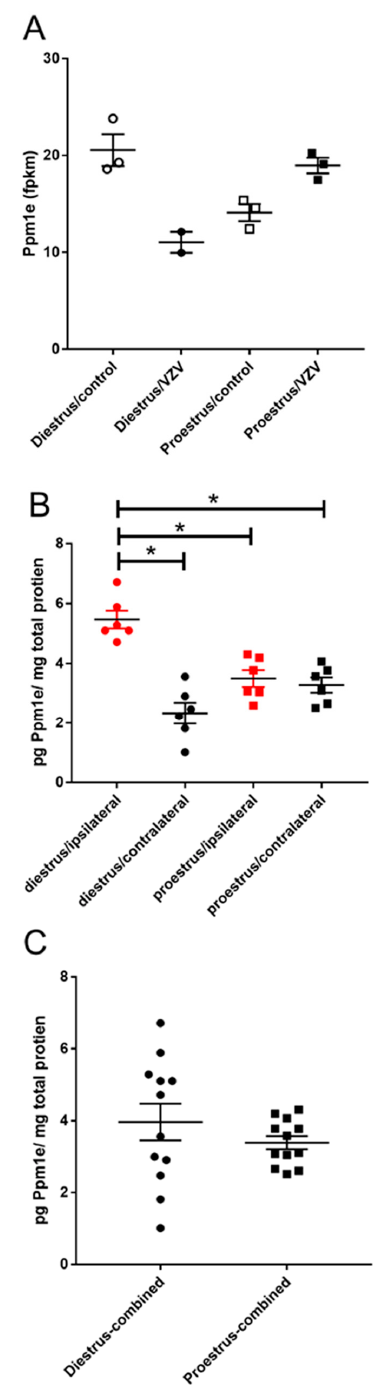
Figure 5. Expression of protein phosphatase, Mg 2 + / Mn 2 + dependent 1E (Ppm1e) significantly increased in the parabrachial region at diestrus. Rats were injected with varicella zoster virus in the left whisker pad to induce orofacial pain. Parabrachial brain tissue was collected from these female rats during the proestrus and diestrus phase of the estrous cycle. This tissue was analyzed for RNA (panel A ) and protein (panels B , C ). In panel ( B ) the right (contralateral to VZV injection) and left (ipsilateral to VZV injection) side of the brain was analyzed separately and in panel ( C ) the protein content from both sides of the brain were combined. Fragments Per Kilobase of transcript per Million mapped reads (fpkm). The asterisk indicates a significant di ff erence between groups p <